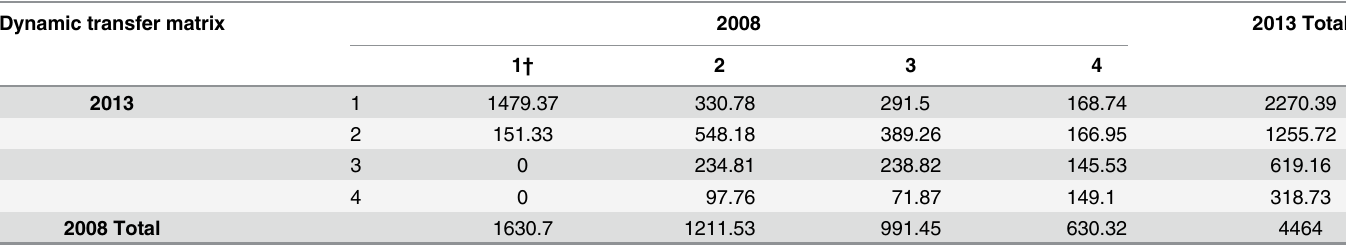
Table 4. Transfer matrix of soil erosion of the ecological restoration area during 2008 – 2013 (km 2